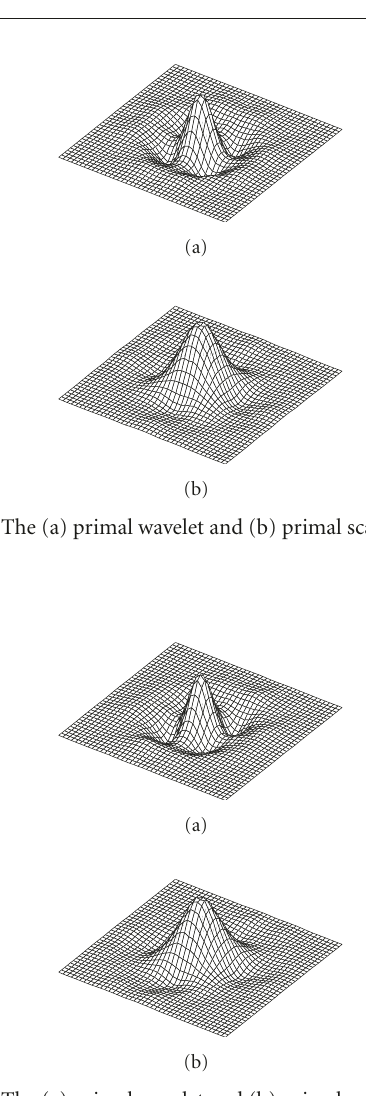
Figure 12: The (a) primal wavelet and (b) primal scaling functions for OPT4.